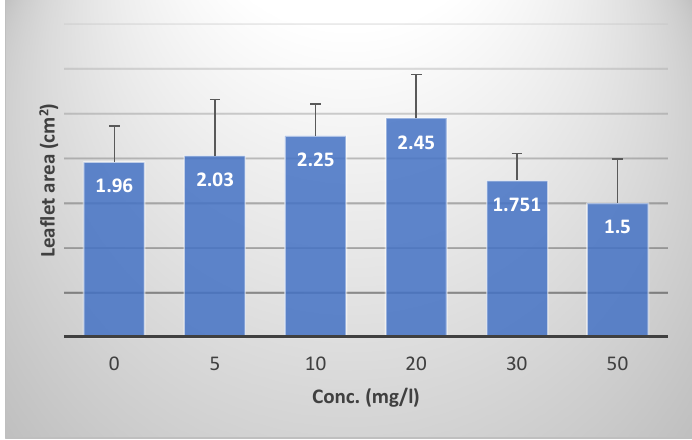
Figure 3. Area of leaflets of Cajanus cajan grown in soils treated with different concentration of SA